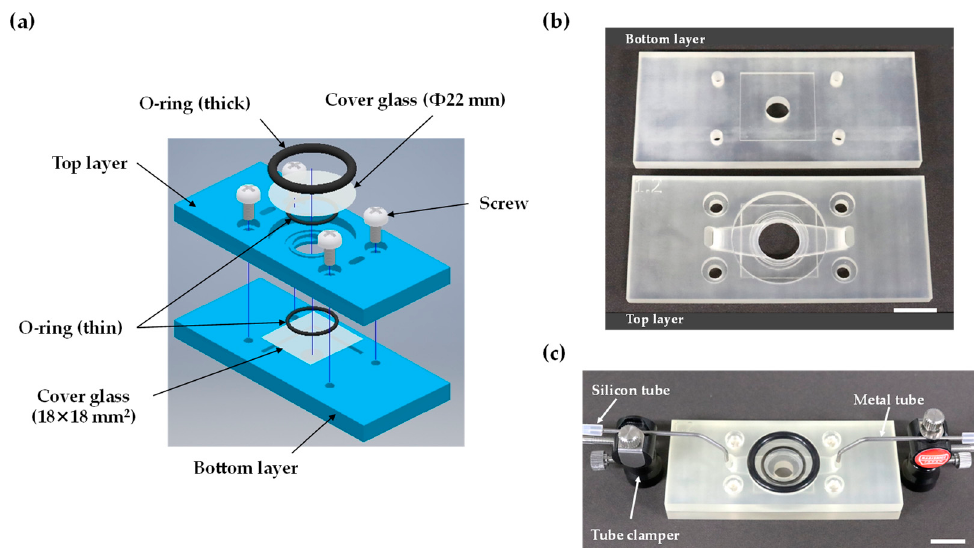
Figure 1. Design and setup of the 3D-printed perfusion cartridge system: ( a ) assembly view of the 3D-printed cartridge; ( b ) two-layer 3D-printed cartridge parts. The top layer includes flow channels and the observation area. The bottom part works as a base; ( c ) cartridge setup for assay buffer perfusion with metal tubes connected to silicone tubes and fixed by tube clampers. All scale bars are 10 mm.